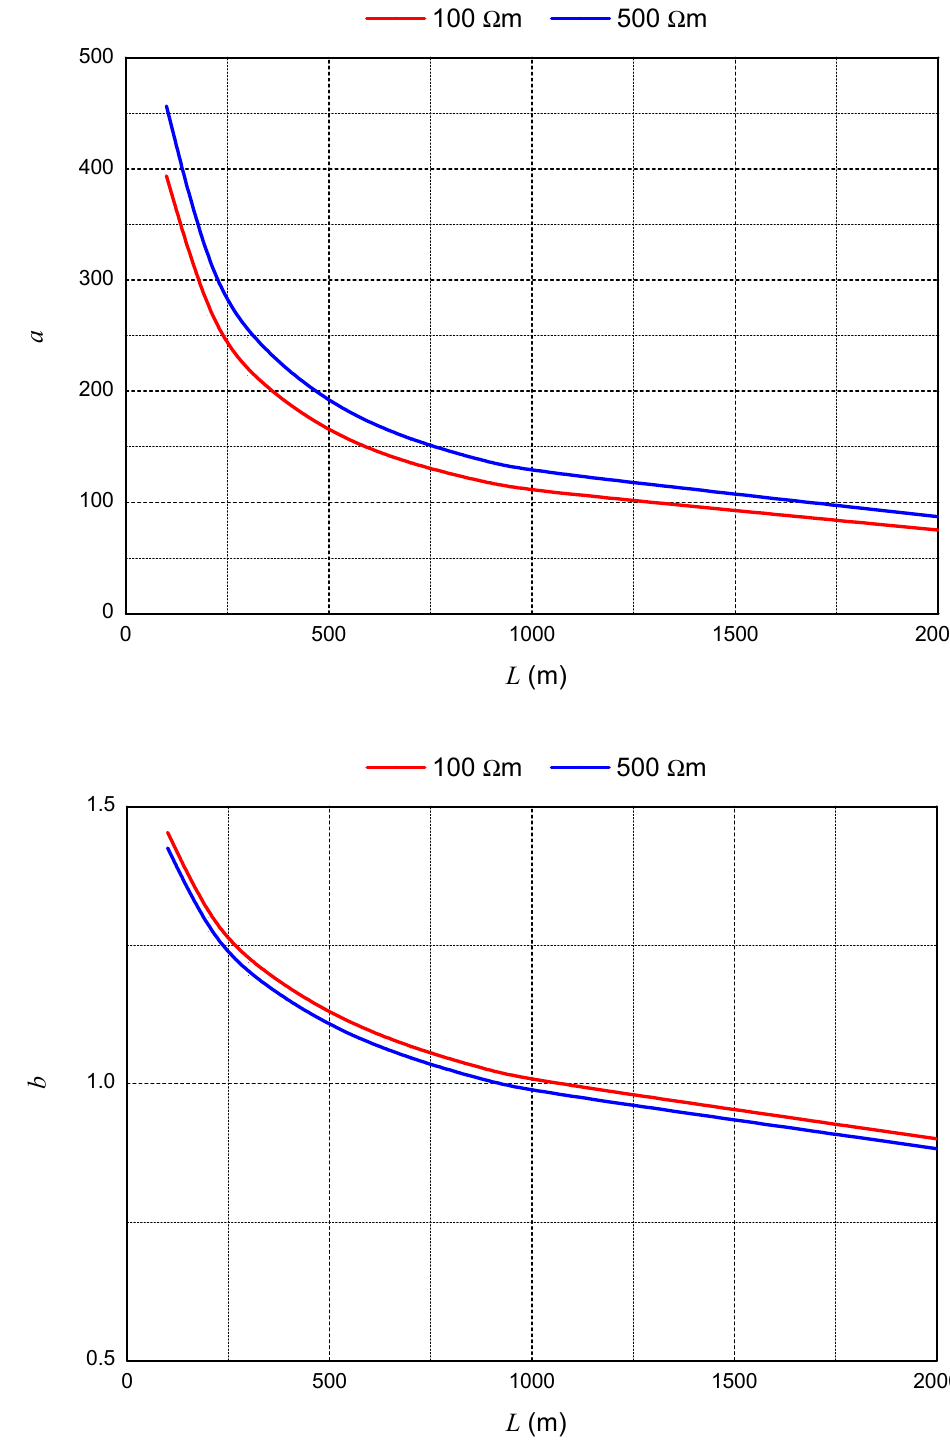
Figure 2. Coefficients a and b as functions of line length L relevant to a normalized ( h = 10 m) HV line, for two values of soil resistivity: ( a ) coefficient a ; ( b ) coefficient b.